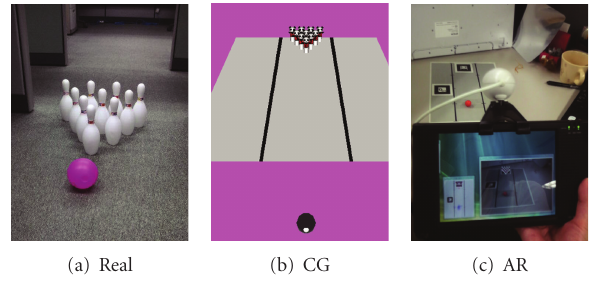
Figure 23: Prepared bowling